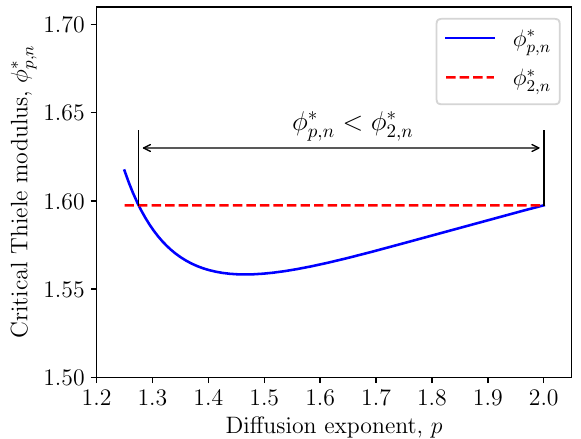
Figure 1. Thiele modulus φ ∗ p , n (solid line) and the threshold φ ∗ 2, n (dashed line) for n